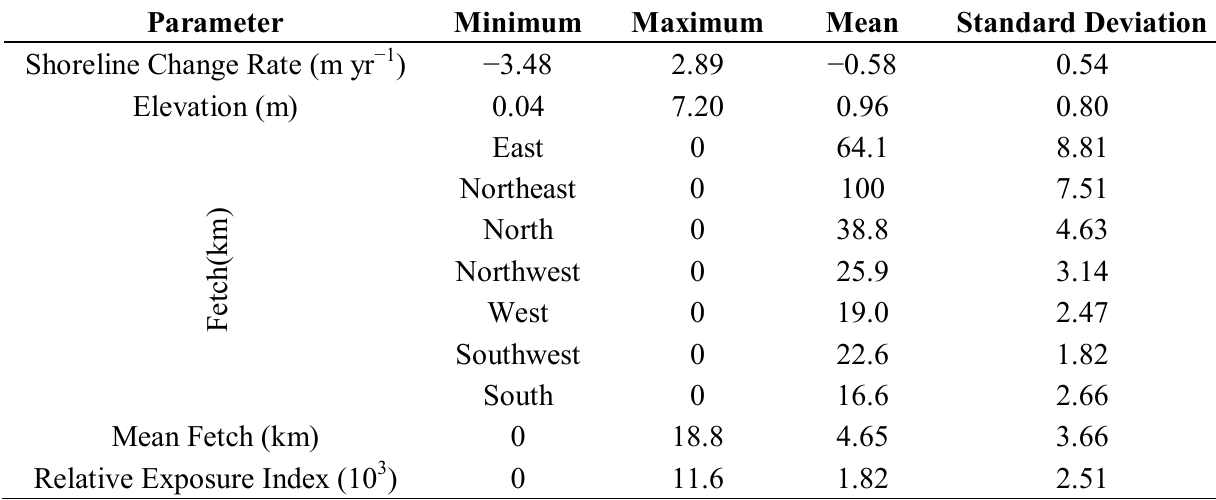
Table 1. Descriptive statistics of parameters measured within the Neuse River